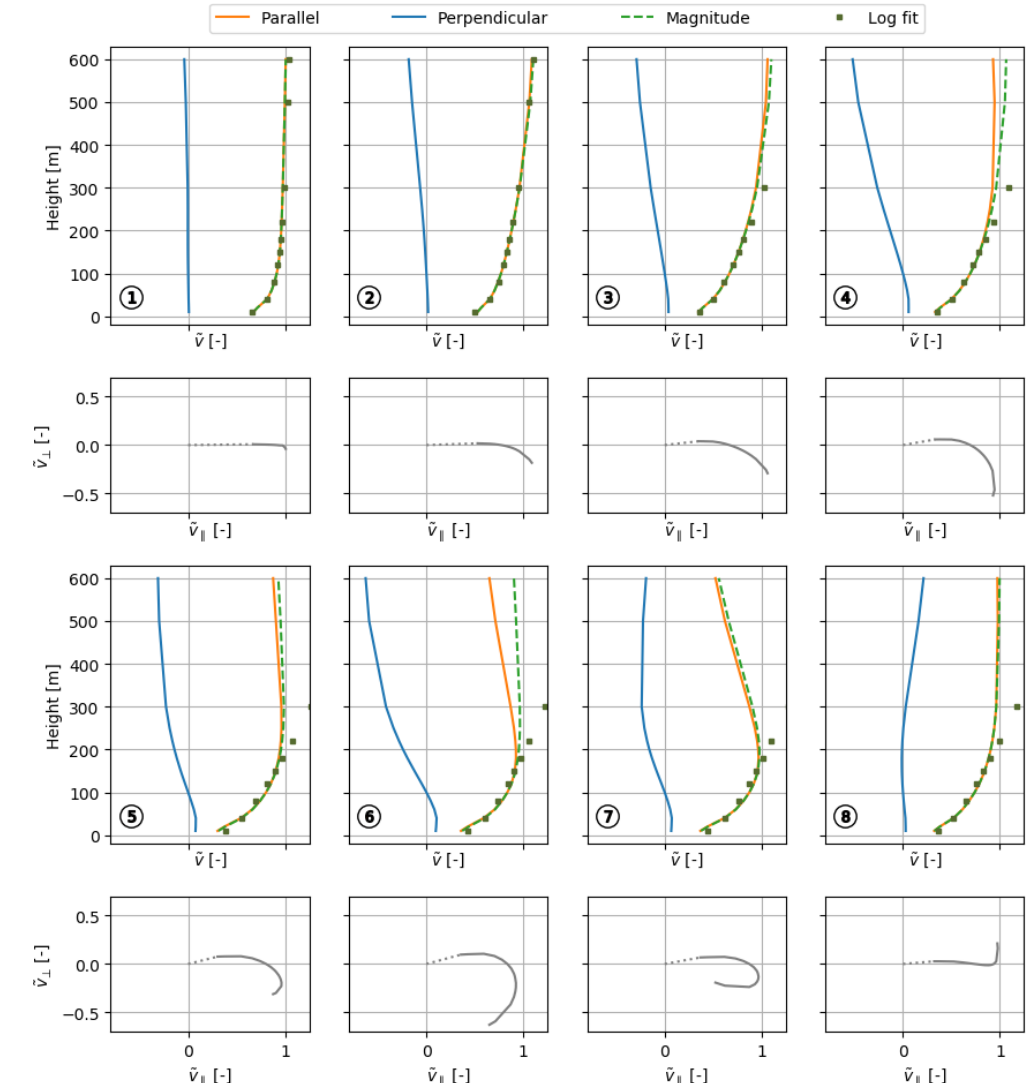
Figure 12. The eight cluster-mean wind profile shapes of the onshore clusters (MMC-1–8). Each shape is depicted by the normalised wind speed components with height (first and third rows) with the corresponding hodograph below (second and fourth rows). Non-adiabatic logarithmic profile fits are plotted alongside the shapes. In each hodograph, the lower end of the profile is indicated by the dotted line connecting the lowest-height point to the origin. All plots share the same x axis.